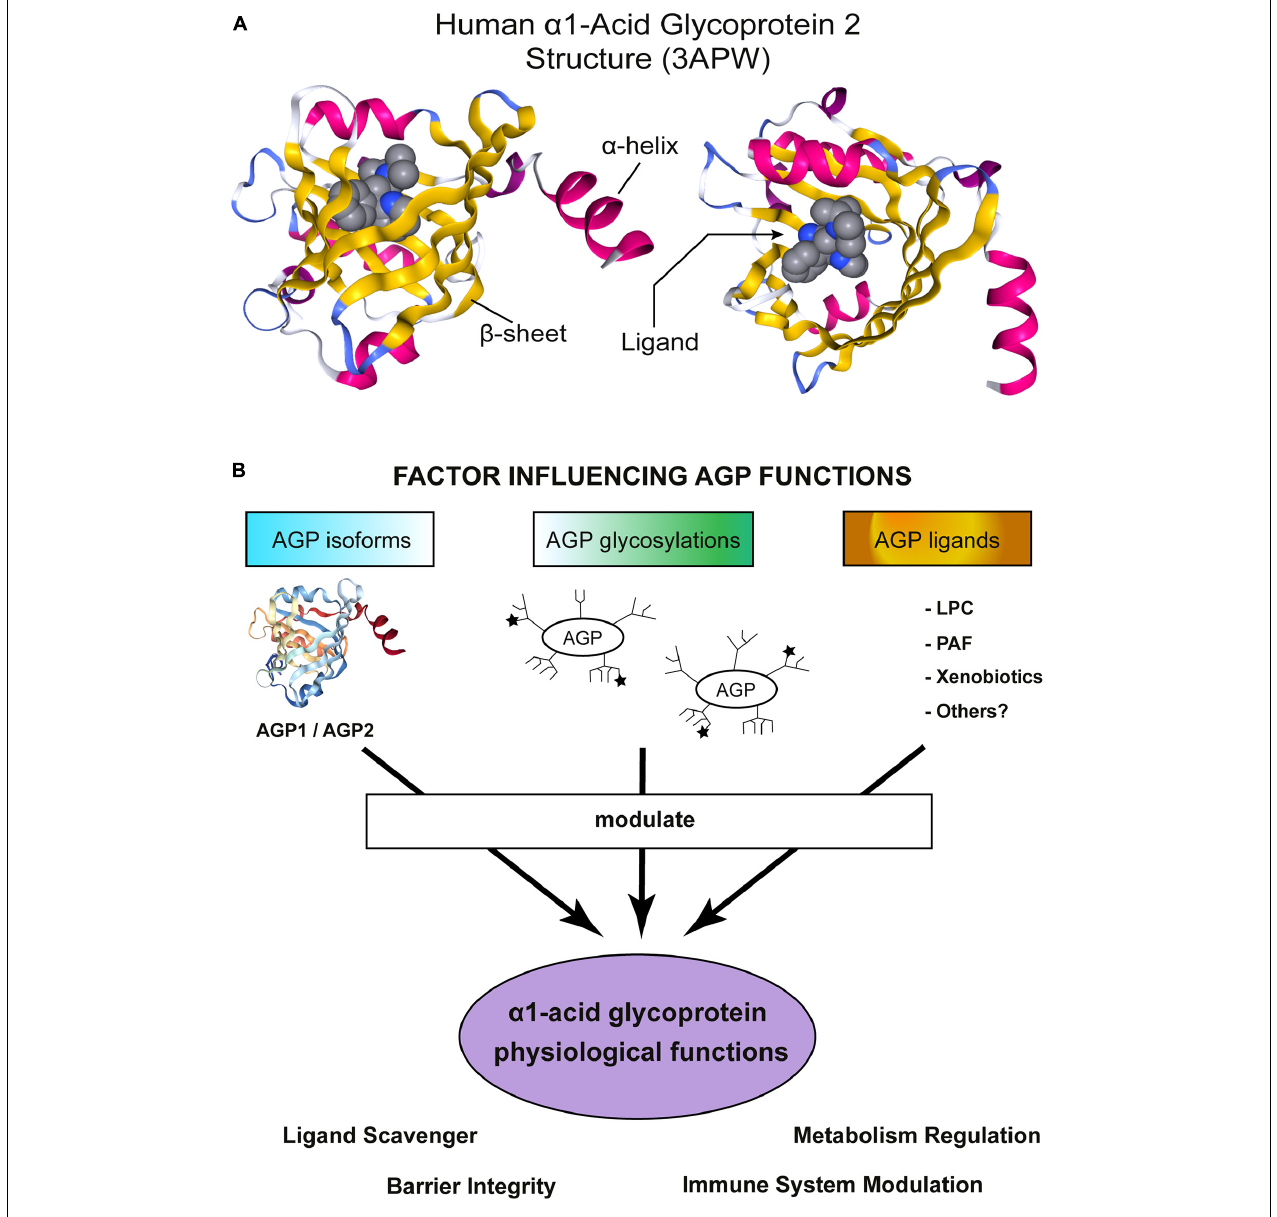
FIGURE 1 | α 1-Acid Glycoprotein (AGP) structure and functions. (A) Schematic representation of hAGP2 structure in complex with a drug in the Lipocalin cavity. In this case the ligand is the antiarrhythmic medication disopyramide (3APW) [originaly published by Nishi et al. (2011)]. The left model is a lateral view of AGP2 and the right model show the view from the top, the open side of AGP β -barrel. The secondary structures are colored: β -sheets in yellow and α -helix in magenta. The ligand (disopyramide) is represented in a bulky format to highlight the cavity inside of AGP2. The figure was generating using NGL viewer (Rose et al., 2018). (B) Schematic representation showing important factors influencing AGP functions. AGP is highly heterogenic and numerous activities in vitro and in vivo have been reported. AGP is an acute-phase protein that modulates the immune system and, recently, AGP has also been shown to regulate the metabolism. AGP tissue/cell type of expression determines which isoform is expressed: AGP1 or AGP2. Then, each tissue counts with a specific set of enzymes to glycosylate proteins and, indeed, multiple glycosylation patterns have been detected in AGP. The (cid:70) symbols represent the possible presence of sLe x groups. Note that the schematic cartoon of the glycosylation does not represent the actual complex and heterogeneous AGP glycosylation pattern. More detailed information can be found in Baerenfaenger and Meyer (2018), Keser et al. (2021). Finally, the environment where AGP is secreted allows to bind/scavenger a different set of ligands, Indeed, an enormous number of compounds are efficiently bound by AGP. The sum of all the above-mentioned factors would contribute to AGP physiological functions.